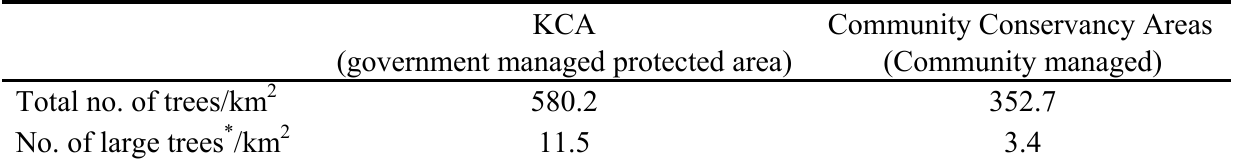
Table 1. Density of large trees within each of the two land management types – KCA,